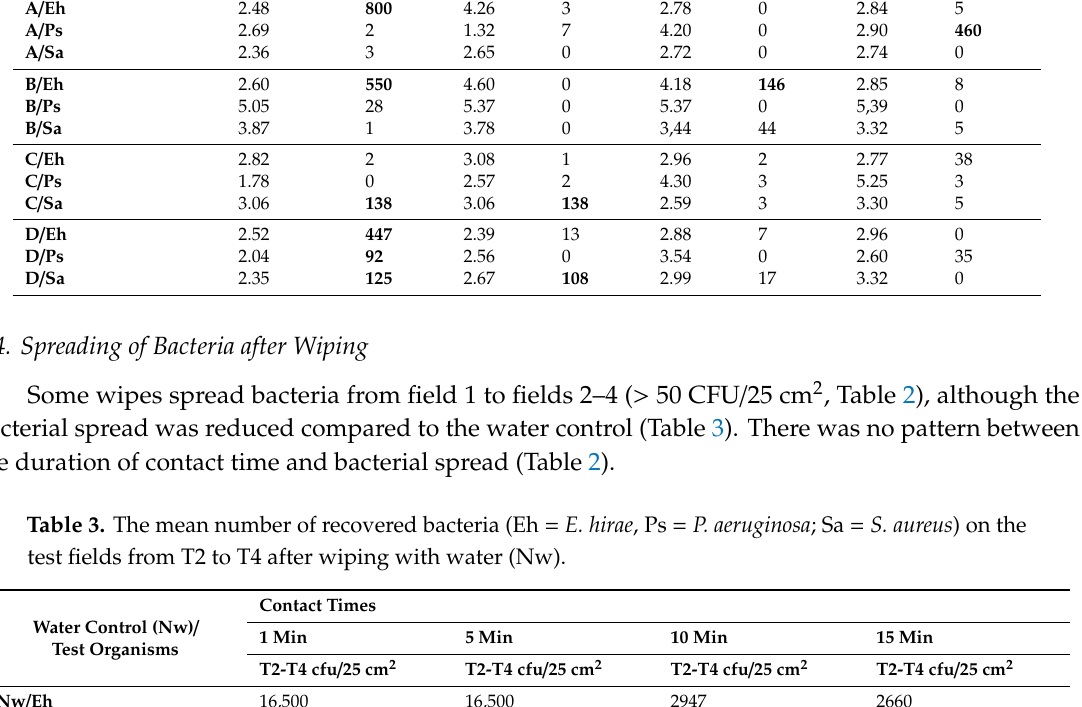
Table2. Log-reduction(lgR)andthespreadofbacteria(Eh = E.hirae , Ps = P.aeruginosa andSa = S. aureus ) on the test fields from T2 to T4 per 25 cm 2 after wiping with the tested wipes A, B, C, D at the contact times from 1 to 15 min. Values indicating bacterial spread ( > 50 CFU / 25 cm 2 ) are shown in bold. Wipes / Test Organisms